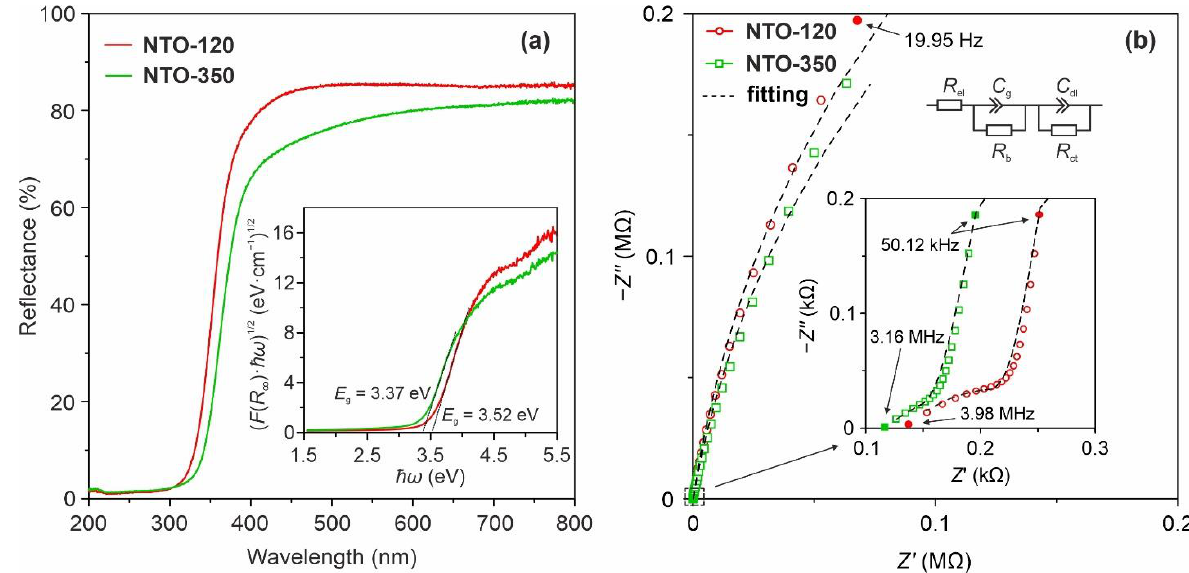
Figure 5. UV-vis diffuse reflection spectra ( a ) with the corresponding Tauc plots (inset) for band gap determination and impedance spectra ( b ) with the EEC used for fitting of NTO-120 and NTO-350 materials (to guide the reader’s eye high-frequency regions of spectra are shown enlarged at the right).